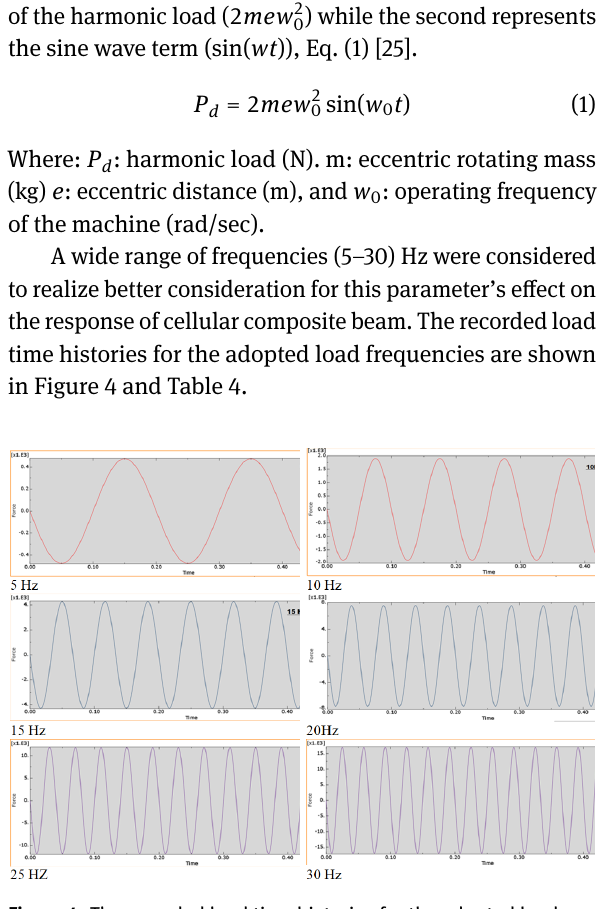
Figure 4: The recorded load time histories for the adopted load frequencies